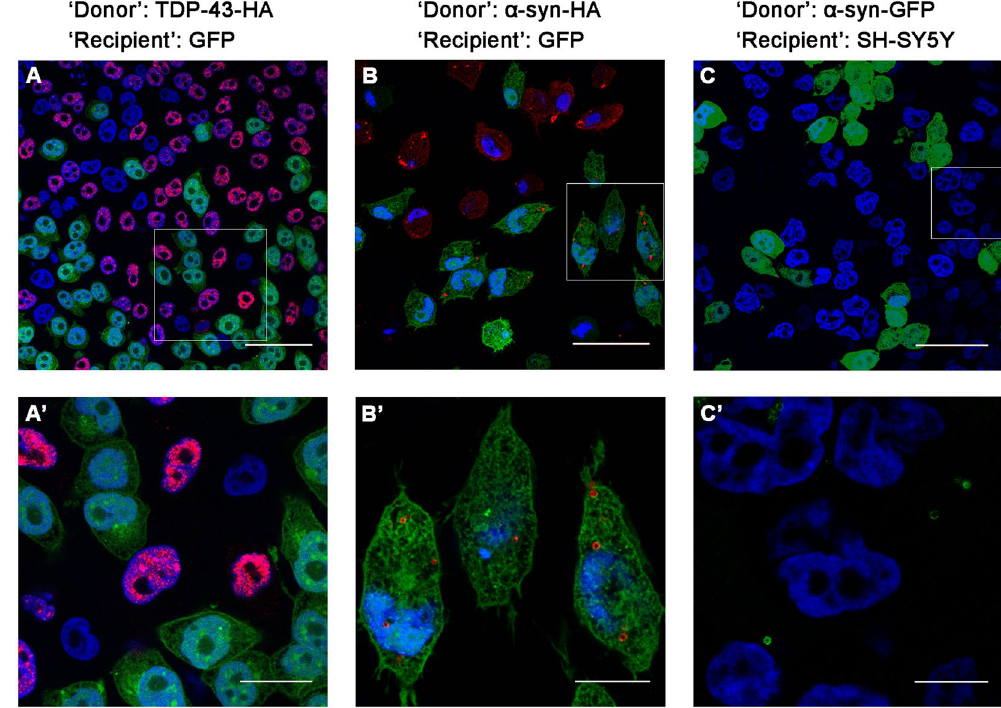
Figure 5. Transmission of tagged TDP-43 and α -synuclein into ‘recipient’ cells. The boxed area in ( A , B , C ) is enlarged in ( A’ , B’ , C’ ), respectively. GFP-expressing ‘recipient’ cells were co-cultured with either HA-tagged TDP-43 ( A , A’ ) or α -synuclein ( B , B’ ) ‘donor’ cells for three days and viewed using confocal microscopy. Alternatively, ‘donor’ cells expressing GFP-tagged α -synuclein were co-cultured with naïve SH-SY5Y ‘recipient’ cells ( C , C’ ). DAPI (blue), anti-HA-antibody (red). Scale bars: ( A ) (50 µ m); ( A’ ) (20 µ m); ( B , C ) (40 µ m); ( B’ ) (12 µ m); ( C’ ) (8 µ m).